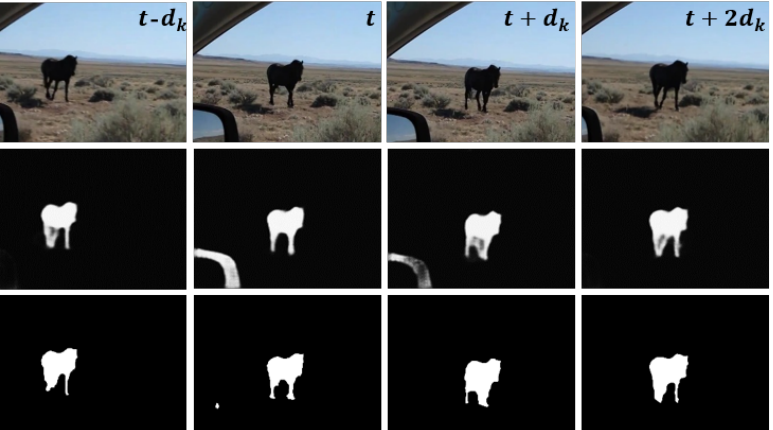
Figure 6. Performance of the proposed neighborhood reversible flow. The first row is the video sequences from Youtube-Objects [1], the second row is the corresponding initialized foreground maps, and the third row is the optimized results by neighborhood reversible flow.